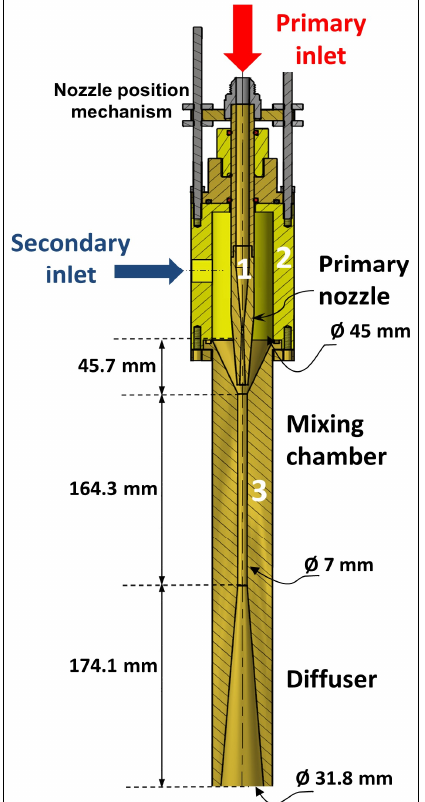
Figure 3. Principal parts and dimensions of the ejector.